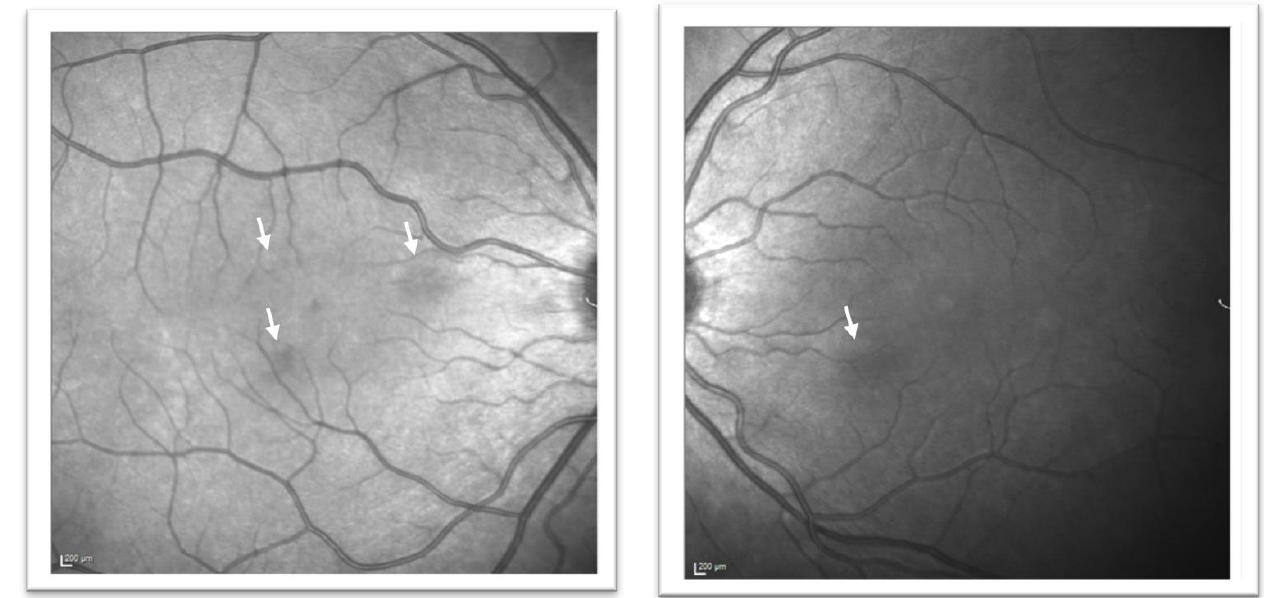
Figure 3. Near-infrared reflectance images in December 2020. The lesions seen on near-infrared reflectance imaging from initial presentation are seen to have become much less prominent over the 10-month period (white arrows).